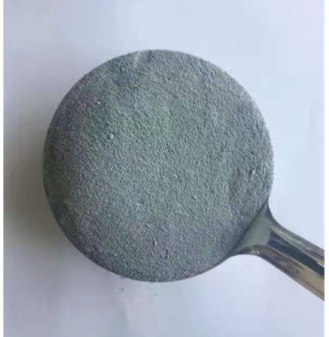
Figure 1. Silica fume sample particles.